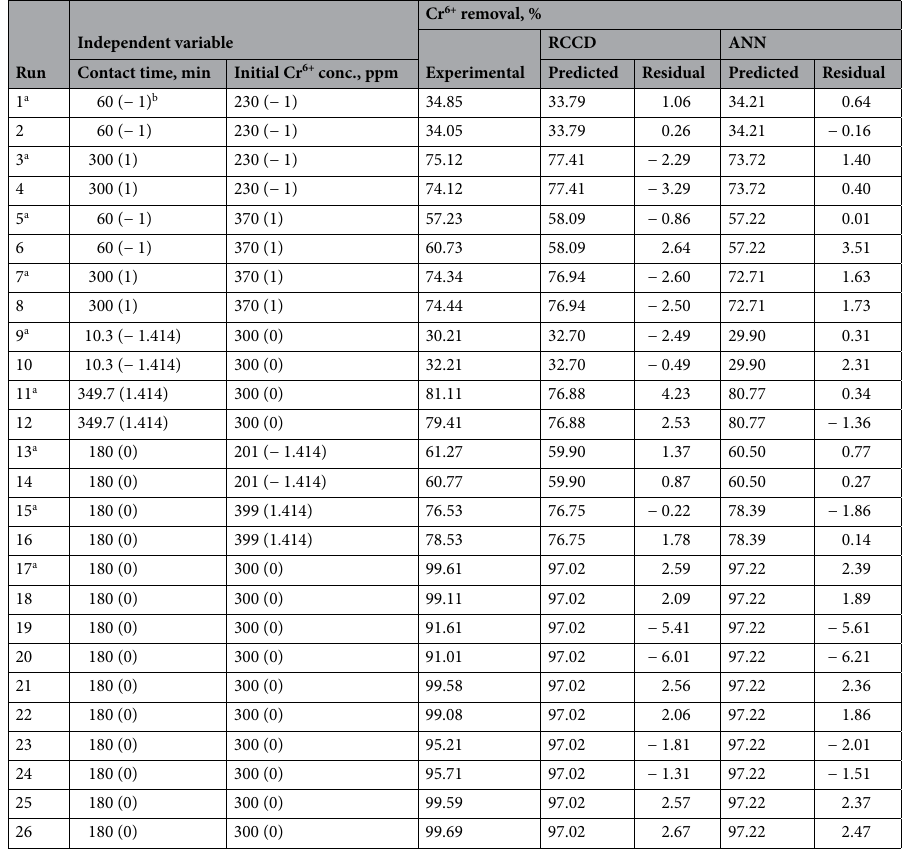
Table 2. Experimental data of Cr 6+ removal, based on the RCCD matrix of the independent factors and the corresponding predicted values obtained of the two tested models (RCCD and ANN). a Nine runs were randomly selected by the software for validating the model of ANN, the other 17 runs were used for training. b The number between parentheses is the coded values of the tested parameters.